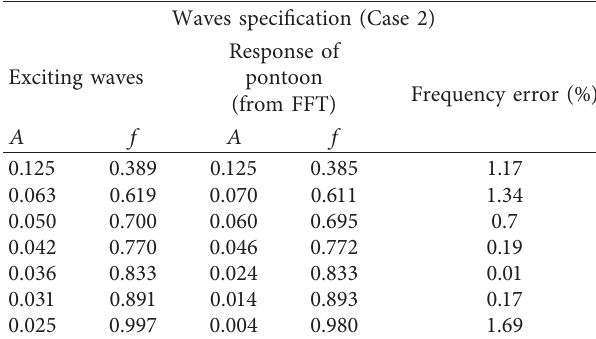
Table 5: Amplitude and frequency of the heaving pontoon in Case 2.